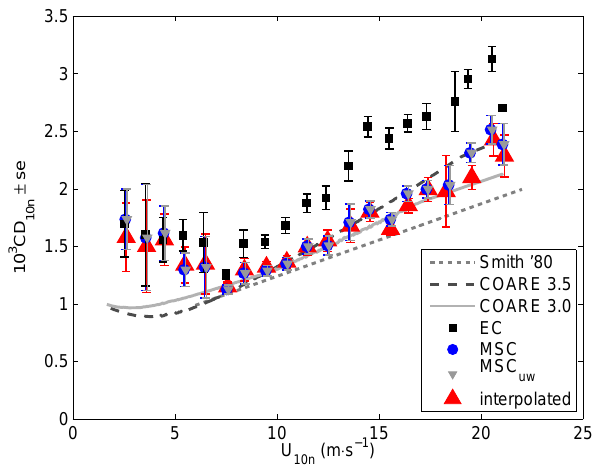
Figure 3. Drag coefficients bin-averaged by wind speed, relative to U 10n ( n = 499). Four versions of the measurements are shown: without correction for wave-scale bias (EC); with correction ap- plied to the vertical velocity only (MSC); correction applied to both vertical and horizontal velocity components (MSC uw ); and correc- tion via a simple interpolation across the wave-scale portion of the cospectra (interpolated). The bulk COARE 3.0 and 3.5 results are calculated without dependence on wave field or